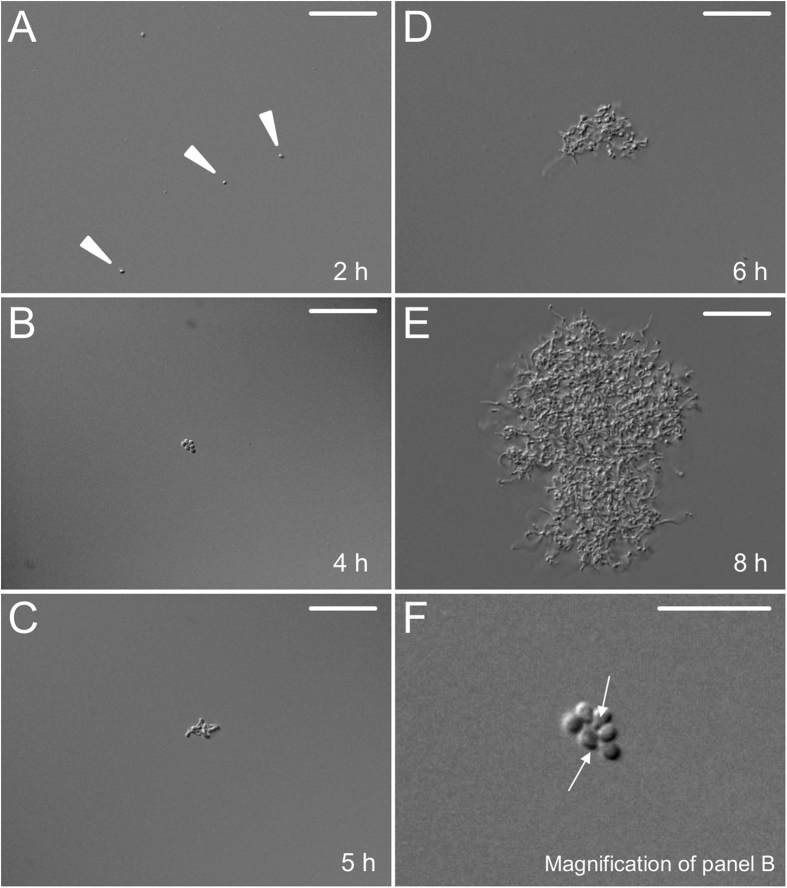
Microscopy analysis of early stages of growth and aggregation.Wild-type spores of S. lividans were inoculated in TSBS medium. Only individual spores (arrowheads) are observed 2 h after inoculation (A). Aggregation becomes visible after 4 h of growth (B) coinciding with the appearance of germ tubes (see also panel F). Further aggregation and growth leads to the formation of particles that increase in size over time (C–E). Panel (F) shows a magnification of the aggregate visible in panel (B). Arrows indicate germ tubes. Scale bars represents 20 μm (A–E) or 5 μm (F).